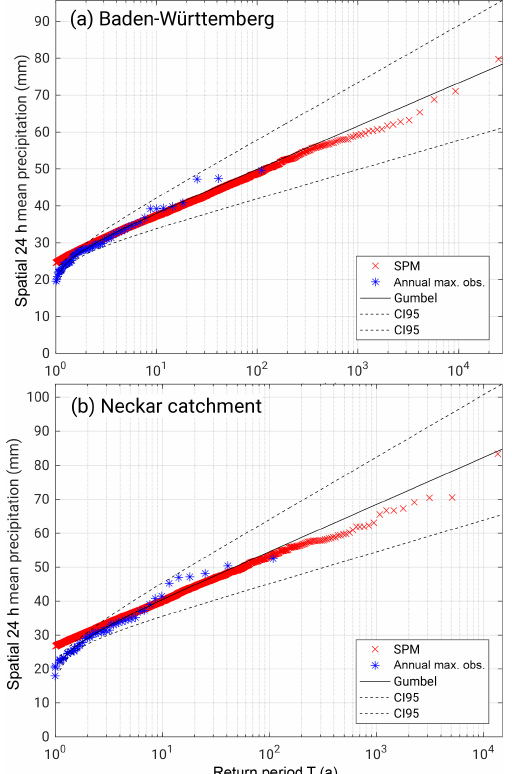
Figure 14. Relative difference of the precipitation amounts for re- turn periods of (a) T = 10 years, and (b) T = 200 years, according to a Gumbel distribution fitted to the observations (top200) and the SPM2D (see text for further explanation). The Neckar catchment is shown as green contour.